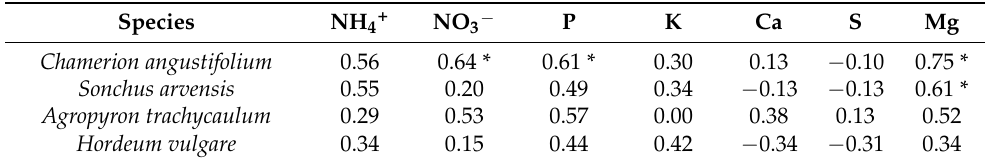
Table 2. Spearman rank correlations between plant aboveground biomass and nutrient supply rates across substrates and watering treatments. Statistically significant correlations are marked with asterisk.